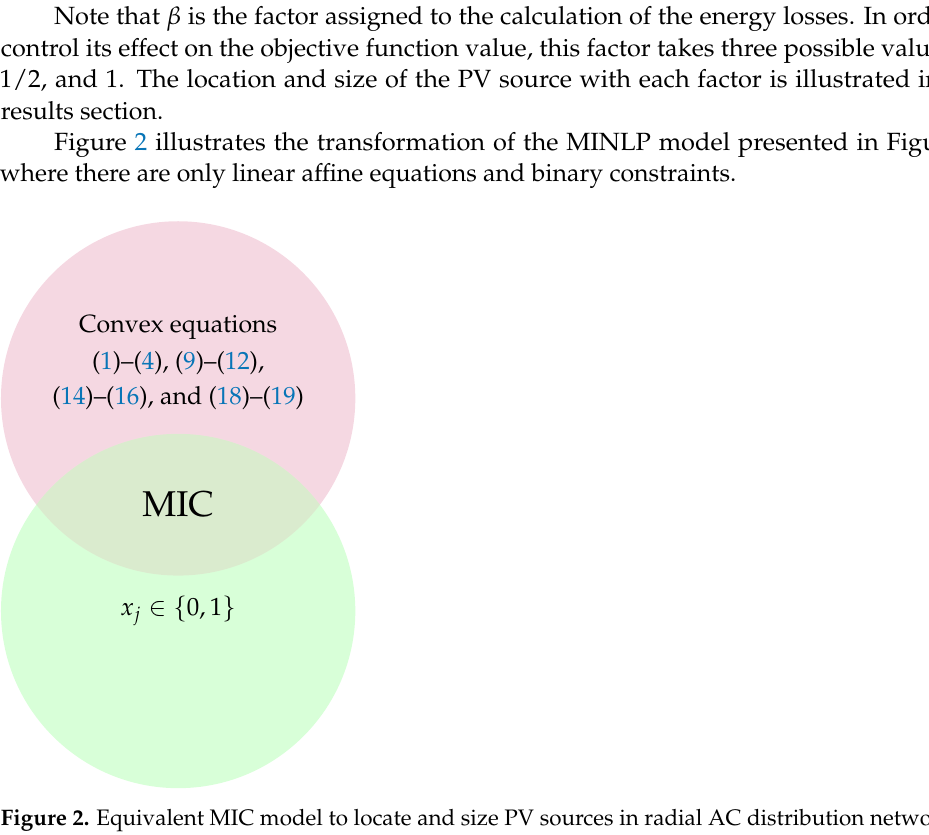
Figure 2. Equivalent MIC model to locate and size PV sources in radial AC distribution